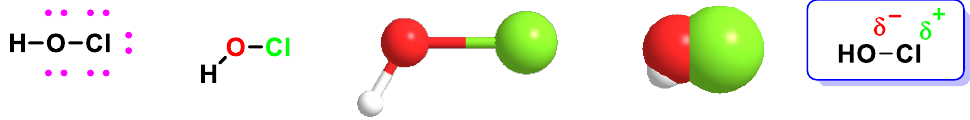
Figure 5. In hypochlorous acid, the chlorine – oxygen bond is polarised as shown in the figure, so Cl + will act as an electrophilic reactant. will act as an electrophilic